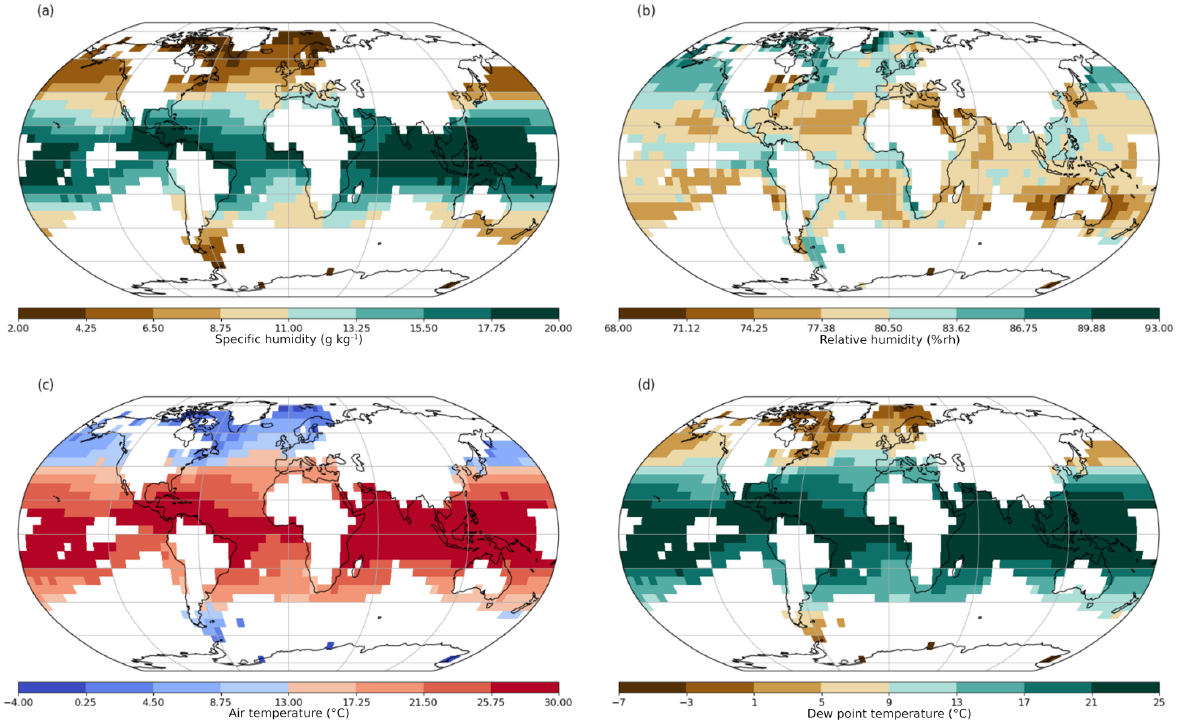
Figure 7. Annual mean climatologies relative to 1981–2010 for (a) specific humidity (gkg − 1 ), (b) relative humidity (%rh), (c) air tempera- ture ( ◦ C), and (d) dew point temperature ( ◦ C) for third-iteration quality-controlled and bias-adjusted ship version. Climatological means are calculated for grid boxes and months with at least 10 years present over the climatology period. Annual mean climatologies require at least 9 months of the year to be represented